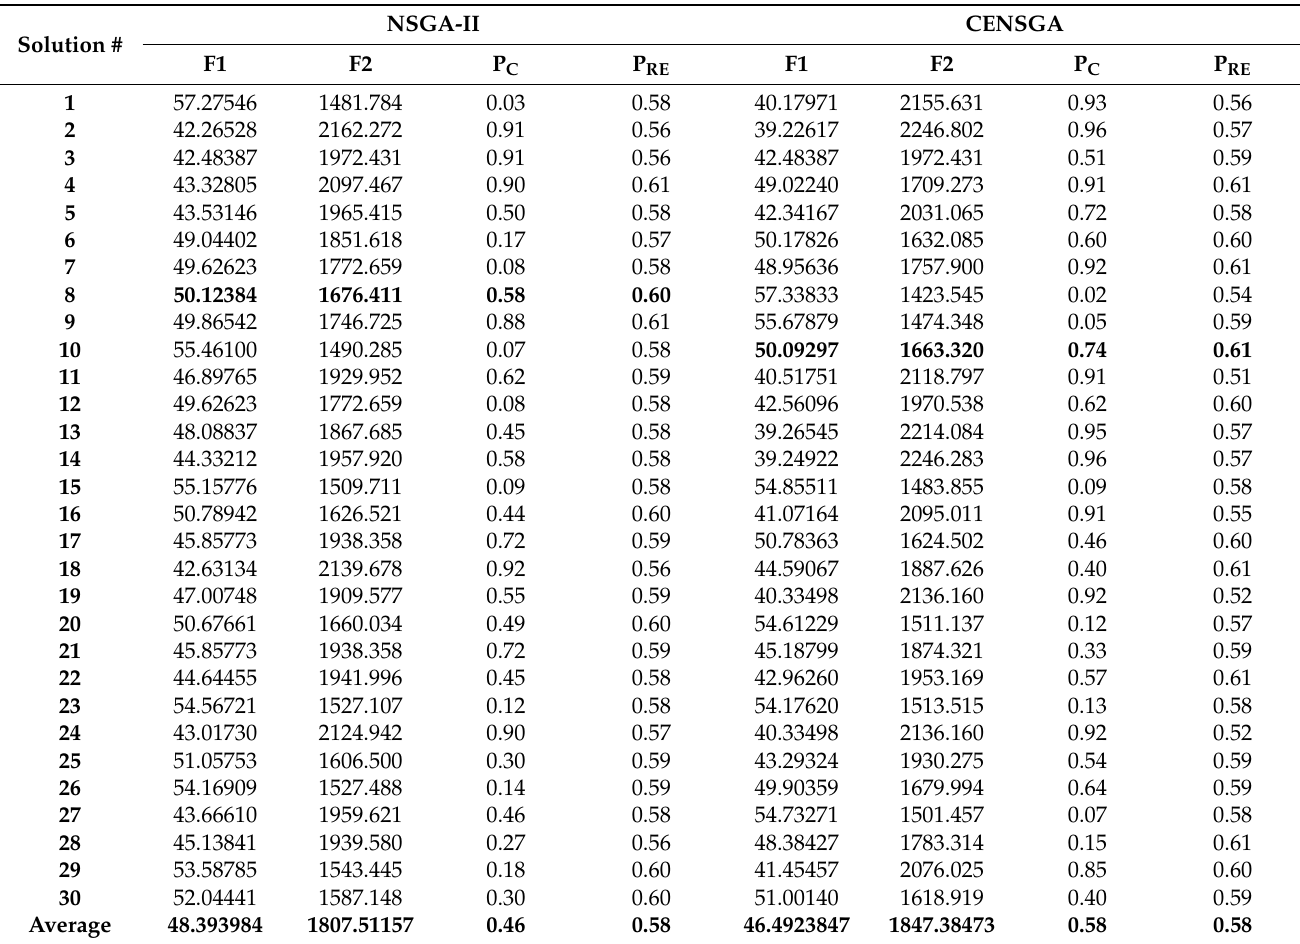
Figure 10. Non-dominated Pareto front of the contingent phase problem. ( A ) NSGA-II, ( B ) CENSGA. A fast non-dominated sorting procedure was executed using the objective functions of the final hash table. A partial set of the sorted non-dominated set of robust complete control policies is presented in Table 4. This table shows the top 30 solutions’ objective function values. Two probabilities are defined: P c indicates the disease is “under control” after the end of the contingent phase, calculated as the ratio of realizations in which the number of infected individuals approaches 0.01 N or below; and the probability of disease eradication, P RE , is defined as the ratio of realizations in which R EF is under one within the simulation time horizon. Table 4. Top 30 non-dominated